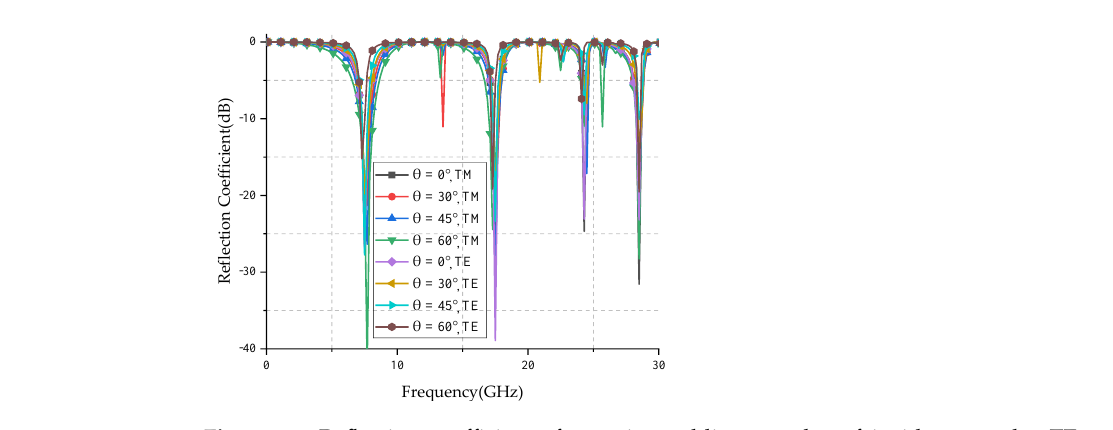
Figure 9. Reflection coefficients for various oblique angles of incidence under TE- and TM-polarized waves. Table 3. The resonance frequency and offset of the proposed FSS for different waves incident modes at different angles.